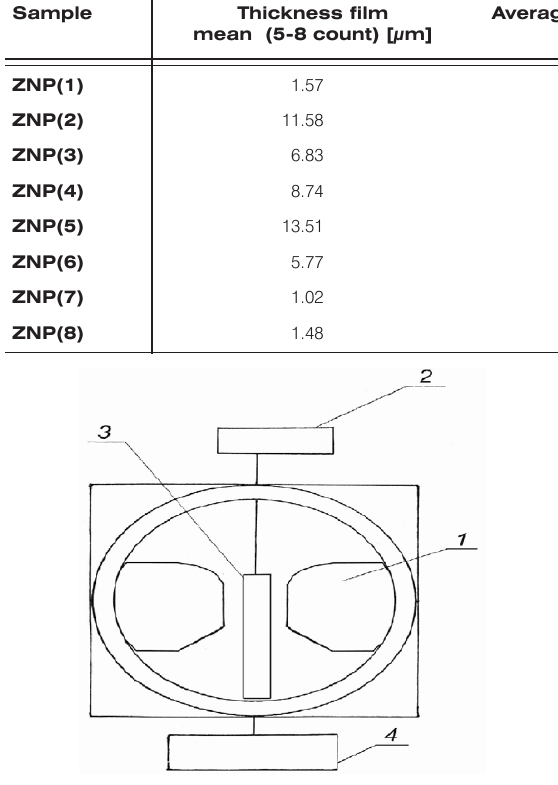
Figure 2. Block diagram for magnetic measurements installation: 1.electromagnet; 2.device for the registration of sample retraction force in magnetic field; 3.sample unit and thermostat; 4.device for thermostat evacuation.